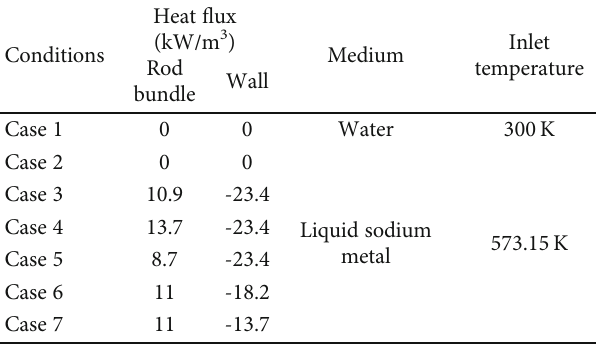
Figure 2: Mesh sensitivity analysis. Table 2: The parameter settings under di ff erent